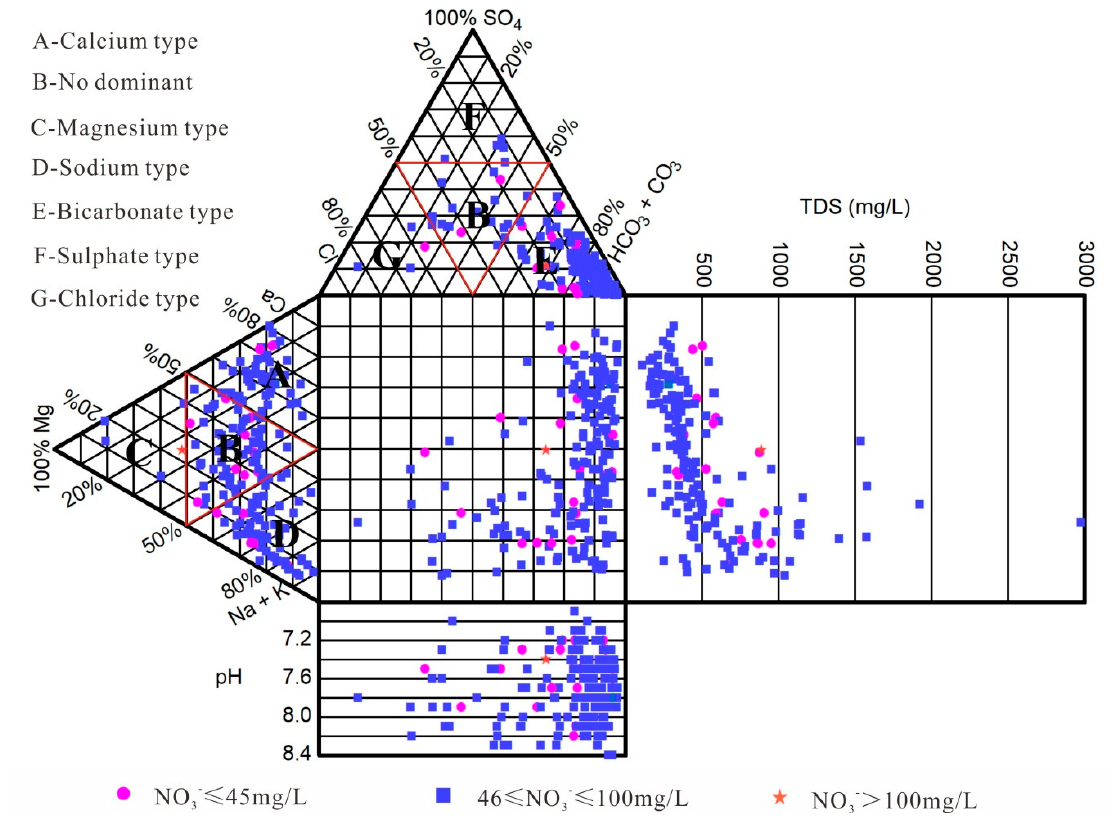
Figure 2. Durov diagram representing groundwater types.